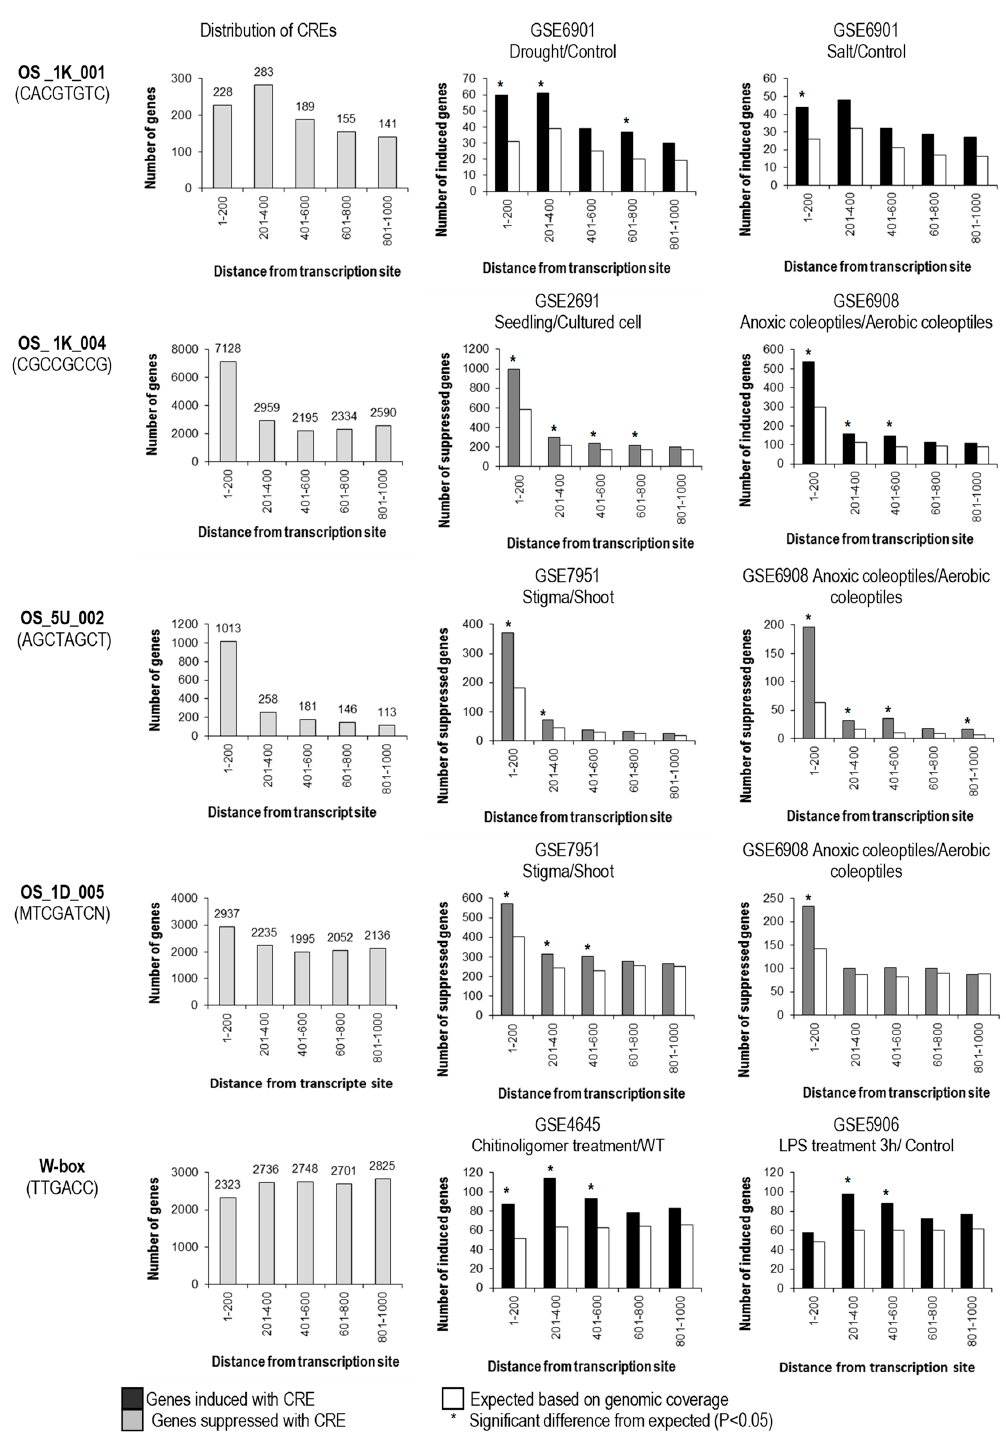
Figure 2. Distribution of CREs within the 1-kb upstream sequence from the transcription start site and positional requirement for the effectiveness of CREs. Genes bearing CREs (shown at the right panel) in different locations upstream of the promoter were subdivided and assayed separately for a significant effect on regulation. By comparison to expected number regulated genes randomly drawn from the genome (white bars), CREs at different positions were scored as having a significant (*; P < 0.05) or non-significant effect on regulation in each microarray experiment.